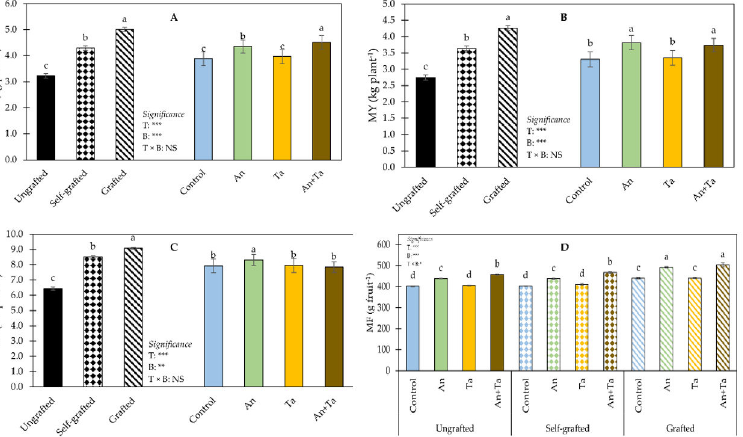
Figure 2. Effect of plant type (T) and biostimulant ( B ) on total yield (TY) ( A ), marketable yield (MY) ( B ), number of marketable fruits (NF) ( C ) and mean weight of marketable fruits (MF) ( D ) of ‘Birgah’ F 1 eggplant. Bars show means ± SE. Bars with same letter are not significantly different accordingly to Tukey’s test at p ≤ 0.05. Significance: NS non-significant; * significant at p ≤ 0.05; ** significant at p ≤ 0.01; *** significant at p ≤ 0.001. An: Ascophyllum nodosum ; Ta: Trichoderma atroviride